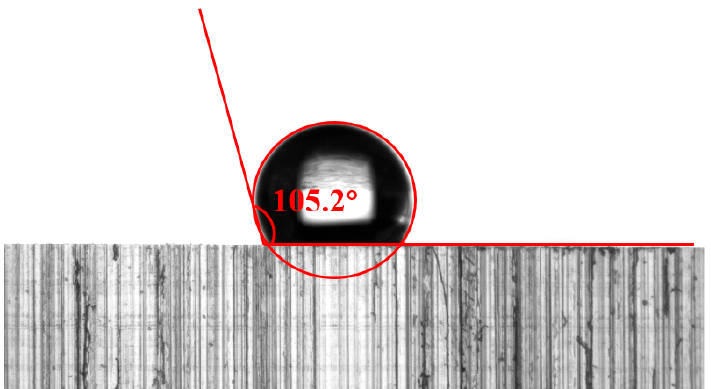
Figure 22. Measurement value of the contact angle of square-column round-table secondary microstructures.